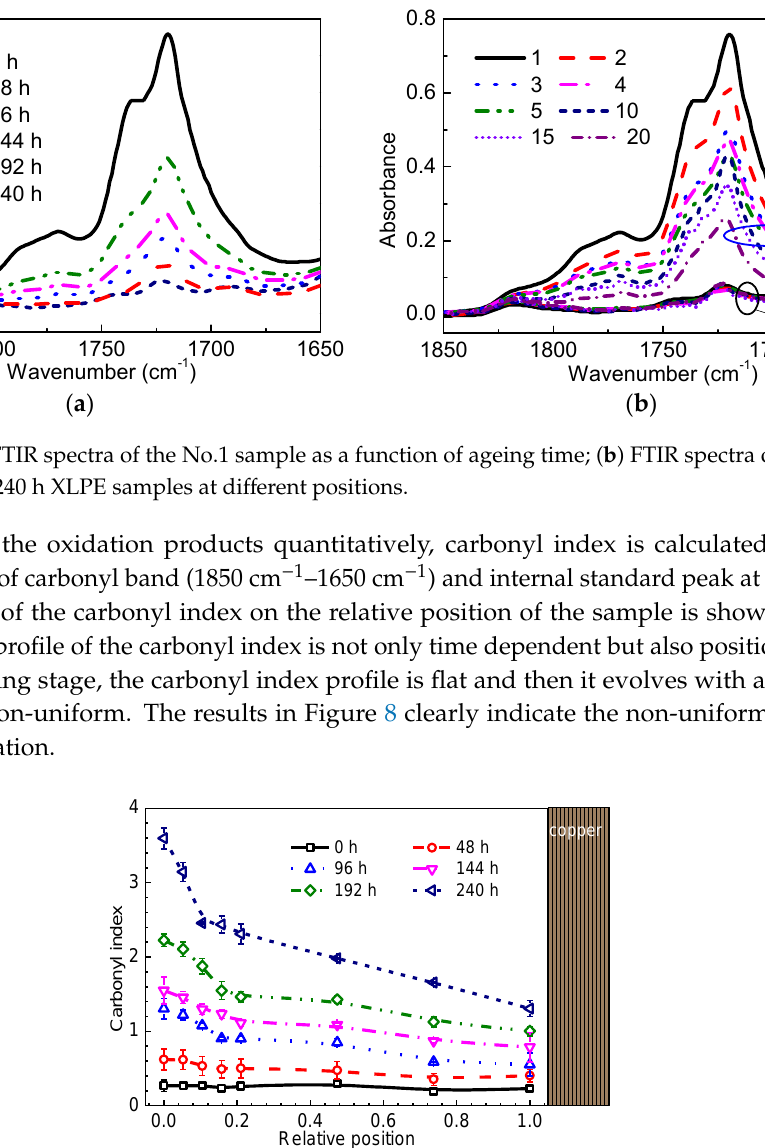
Figure 8. Profile of carbonyl index for different XLPE samples.